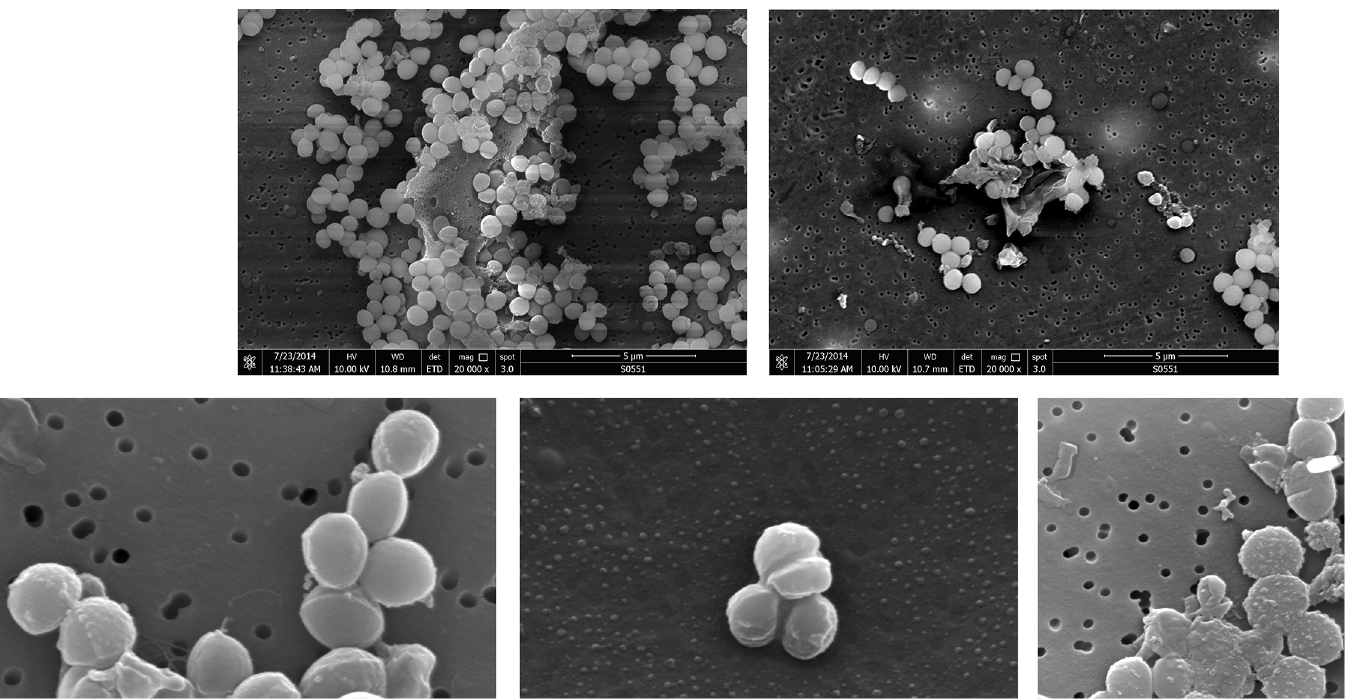
Fig 1. Scanning Electron microscopic analysis. S . aureus ATCC 25923 (A, B and D) and MRSA ATCC BAA-1720 (C and E) bacteria treated with artonin E (bar = 1mm). S . aureus ATCC 25923 after 24 hours (A) untreated and (B and D) exposed to the MIC of artonin E. MRSA BAA-1720 after 24 hours (C) untreated and (E) exposed to the MIC of artonin E for 24 h (bar = 1mm). Images are viewed with (A and B) FEI Quanta 650 FEG ESEM and (C, D and E) JEOL JSM 7001F Field Emission Gun SEM.